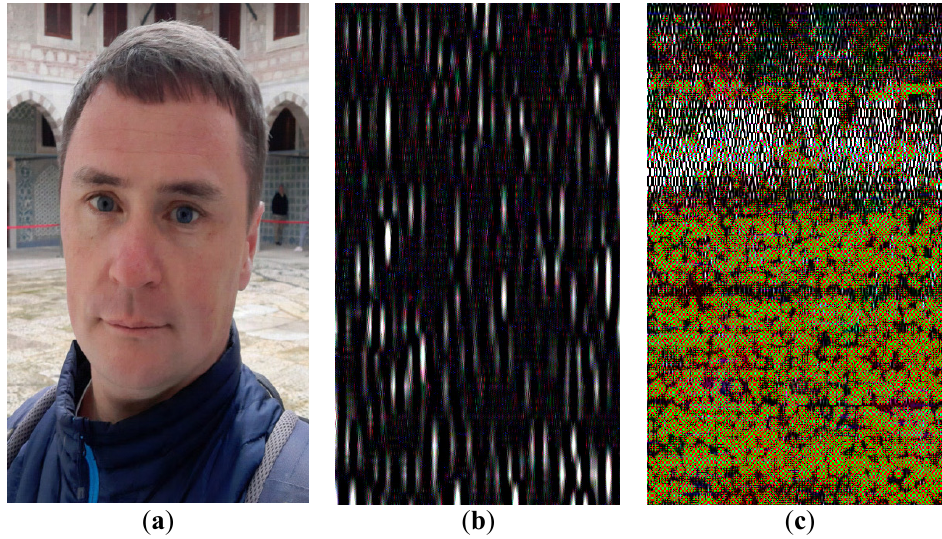
Figure 16. Decompression of the image given in Figure 11a: correct ( a ); incorrect ( b , c